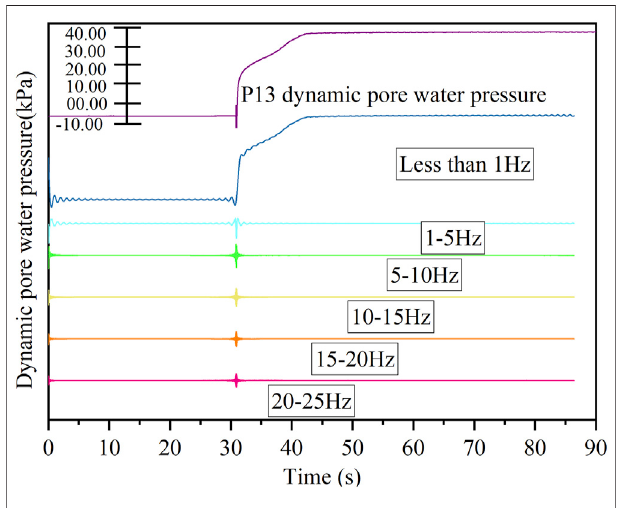
FIGURE 10 | Dynamic pore water pressure time-history curves at bandpass frequencies less than 25 Hz [curves for measurement site P w 13 of the slope model under high acceleration (case 5) are shown as an example here]. These series of subcurves are divided into six frequency bands